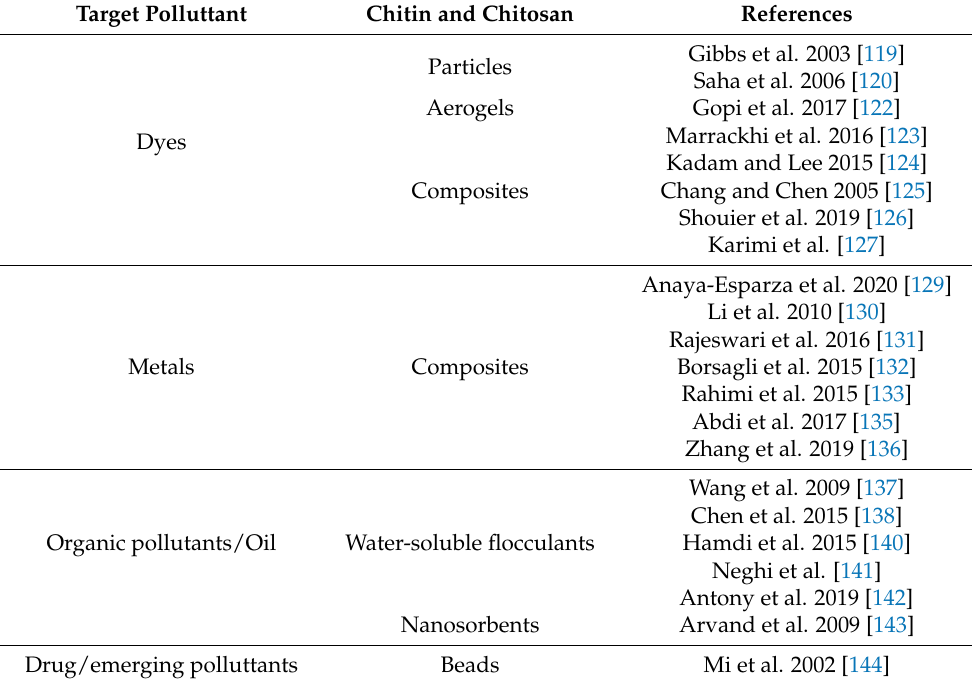
Table 6. Chitins’ and Chitosans’ potential in pollutants’